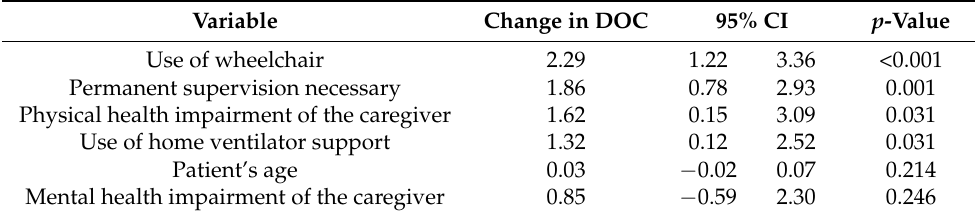
Table 4. Influencing factors on DOC: The DOC score (in hours per day) constituted the dependent variable and patient-related as well as caregiver-related parameters were analyzed as possibly influencing independent variables. This multiple linear regression analysis showed a statistically significant influence of wheelchair use, the necessity of permanent supervision, physical health impairment of the caregiver himself, and the use of ventilation support on the DOC. The model was adjusted for statistical outliers. The results are arranged by p -values. Abbreviations: DOC = duration of caregiving; CI = confidence